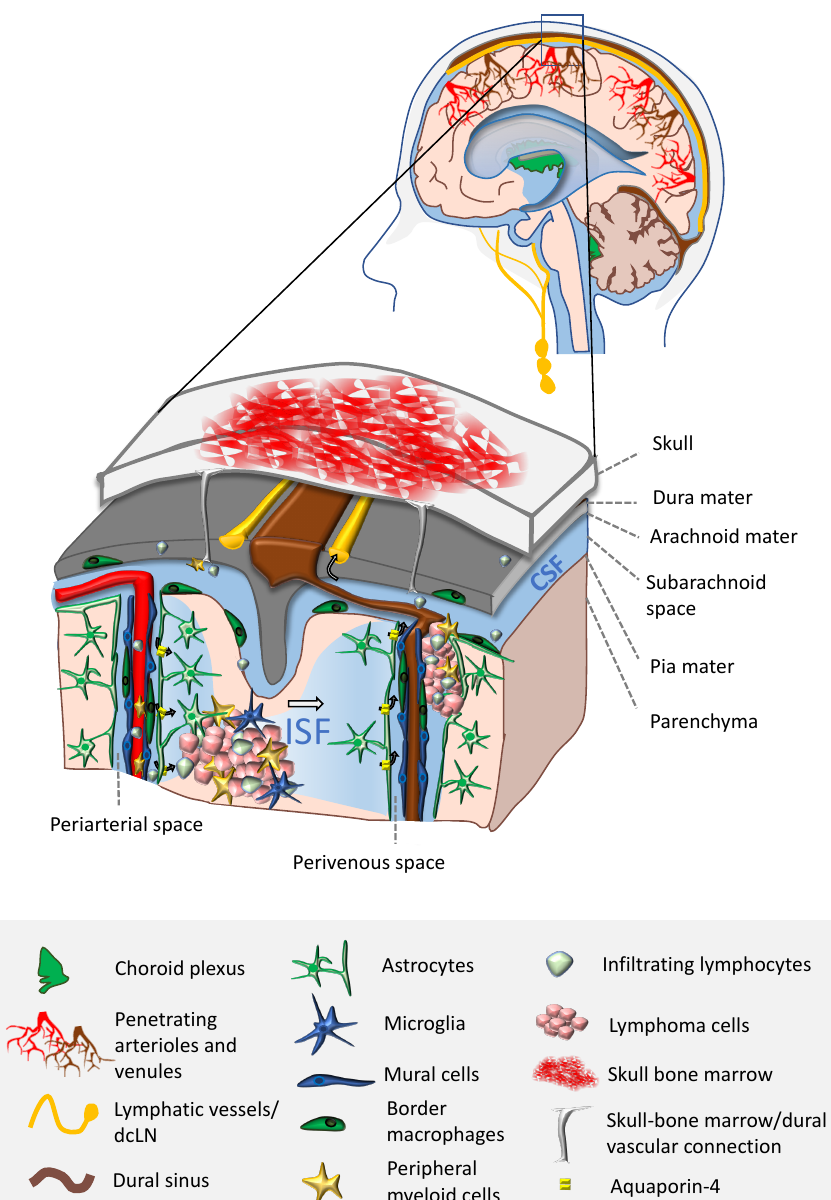
Figure 1. The TME in PCNSL is driven by the unique immune landscape and properties of the CNS. PCNSL are tumors that develop in alternative locations within the CNS. This has an impact on the TME cellular composition. When developing in cerebrospinal fluid (CSF) compartments (perivascular and meningeal spaces), lymphoma cells interact directly with border macrophages, lymphocytes, the glia limitans (formed by astrocytic endfeet), endothelial cells and mural cells (pericytes and smooth muscle cells). Inside the CNS parenchyma, tumor cells are in close contact with microglia, astrocytes and infiltrating immune cells: lymphocytes and peripheral myeloid cells. There are three potential sources of immune cells within PCNSL TME: derived from resident populations, from the blood and also from skull bone marrow reservoirs. Very recently, direct vascular connections between the skull bone marrow and the dura mater were found in mice. Antigens and immune cells from the TME of PCNSL are drained from the CSF compartment into deep cervical lymph nodes (dcLN) through meningeal lymphatic vessels, to potentially elicit anti-tumor responses. It is the role of the glymphatic system to clear CNS solutes, carrying antigens to the CSF compartment. Arrows indicate the directionality of CSF/Interstitial fluid (ISF) bulk flow, which is facilitated by Aquaporin-4 expressed on